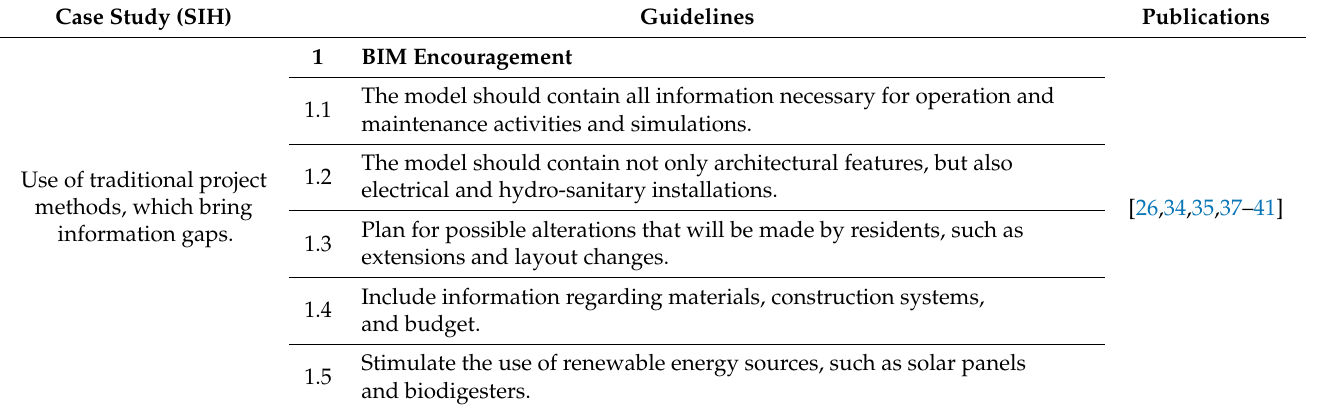
Table 8. Guidelines for implementing BIM for post-occupancy management in future SIH